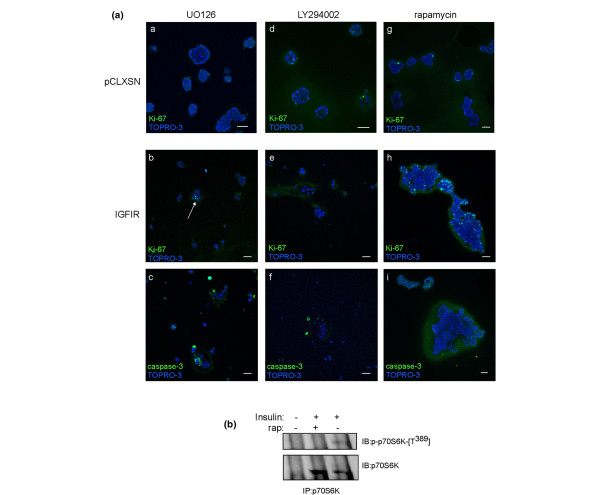
Inhibition of PI3K or MEK but not mTOR disrupts IGFIR acinar development. (a) Confocal sections of 20-day control (pCLXSN, panels a, d, g) and IGFIR (panels b, c, e, f, h, i) acinar structures grown in the presence of the MEK inhibitor, UO126 (10 μm; panels a-c), the PI3K inhibitor LY294002 (50 μm; panels d-f) and the mTOR inhibitor rapamycin (40 nM; panels g-i). Fixed structures were labeled with the nuclear counterstain TO-PRO-3 (blue) and with antibodies to Ki-67 (green; panels a, b, d, e, g, h) or cleaved caspase-3 (green; panels c, f, i). Scale bars = 50 μm. The arrow in panel b indicates Ki-67-labeled cells. (b) Whole-cell lysates of 16d IGFIR acinar structures were isolated after overnight serum starvation followed by 30 minute pretreatment with DMSO (vehicle) or 40 nM rapamycin and subsequent 30-minute incubation with 10 μg/ml insulin. Lysates were immunoprecipitated with antibodies to p70S6K, separated by 12.5% SDS-PAGE, transferred to PVDF and immunoblotted with antibodies to p70S6K or phosphospecific antibodies to Thr389 of p70S6K as indicated.